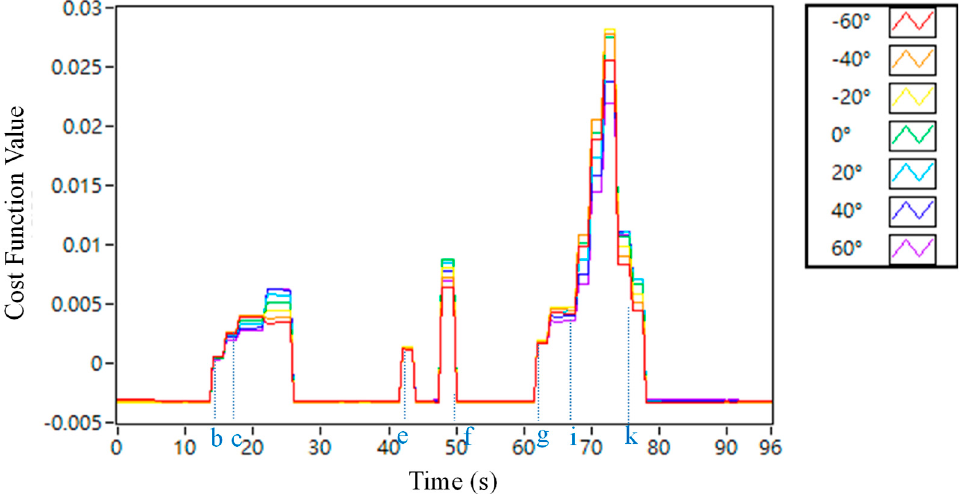
Figure 13. Cost function values of optimum value computing. The horizontal axis is time (s). The vertical axis is the cost function value. The points of the scan map are marked by blue lower-case letters.